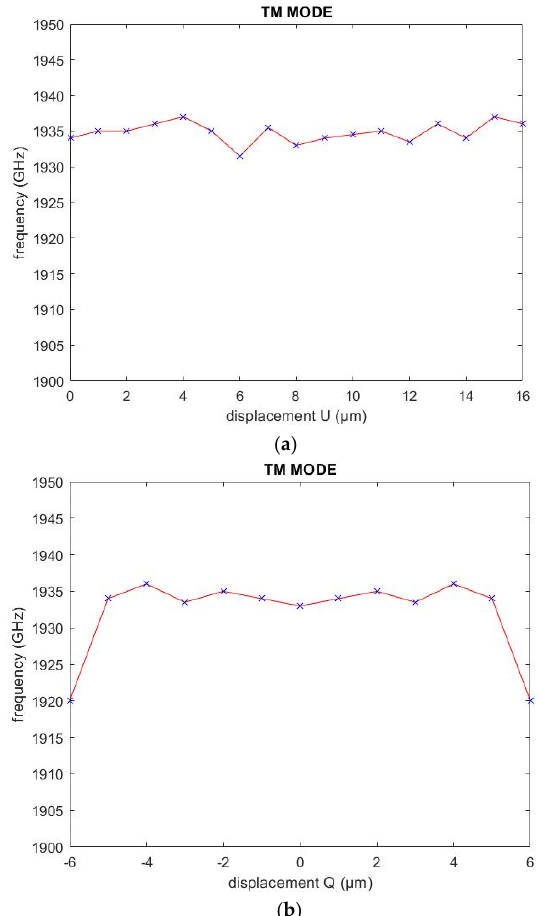
Figure 7. Resonance values while changing the I-shaped position in TM mode: ( a ) change in resonance frequency when moving the center I-column metal bar up in 2 µm increments to a maximum excursion of 16 µm; ( b ) change in resonance frequency when moving the center column right and left in 2 µm up to a maximum excursion of 6 µm for a rightward shift and − 6 µm for a leftward shift. Shifting in this direction is done for a value of U equal to 8 µm, i.e., at the center position of the moving I-shaped column.